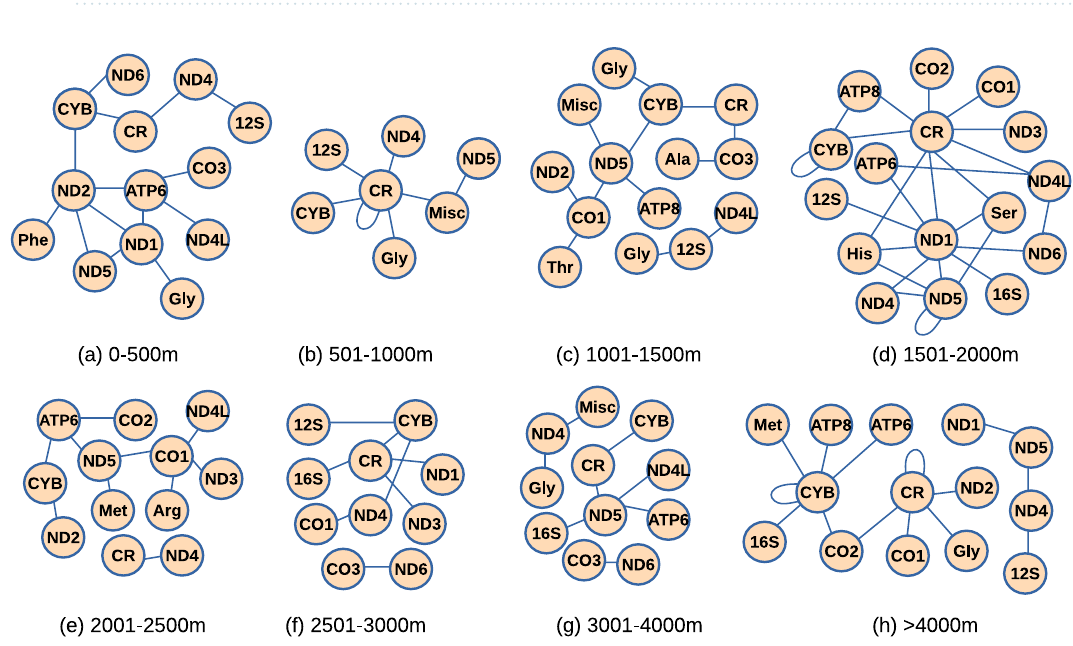
Figure 6. Cluster dendrogram was produced using common nodes between each altitude. It is clearly observed that two clusters are formed, one with groups 1 to 4 (lowest to middle) and other with groups 5 to 8 (middle to highest).